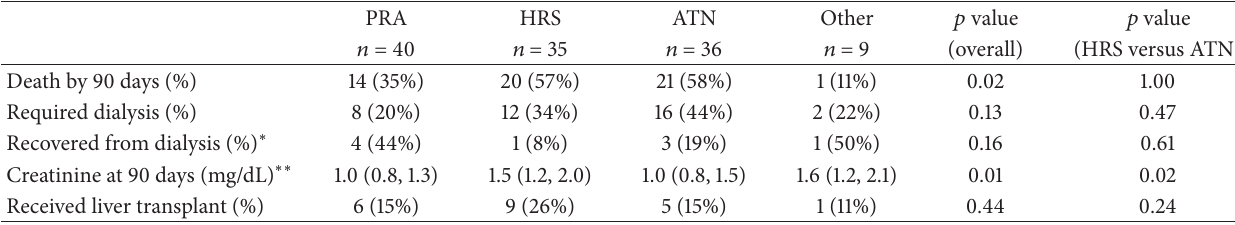
Table 3: Outcomes and variables by type of acute kidney injury.